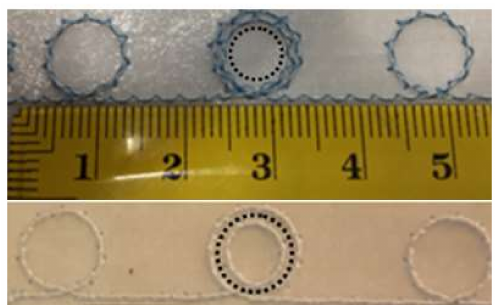
Figure 9. M4 washable RFID tag model with embroidered UHF antenna and transponder arranged inside the circular double loop of the antenna.